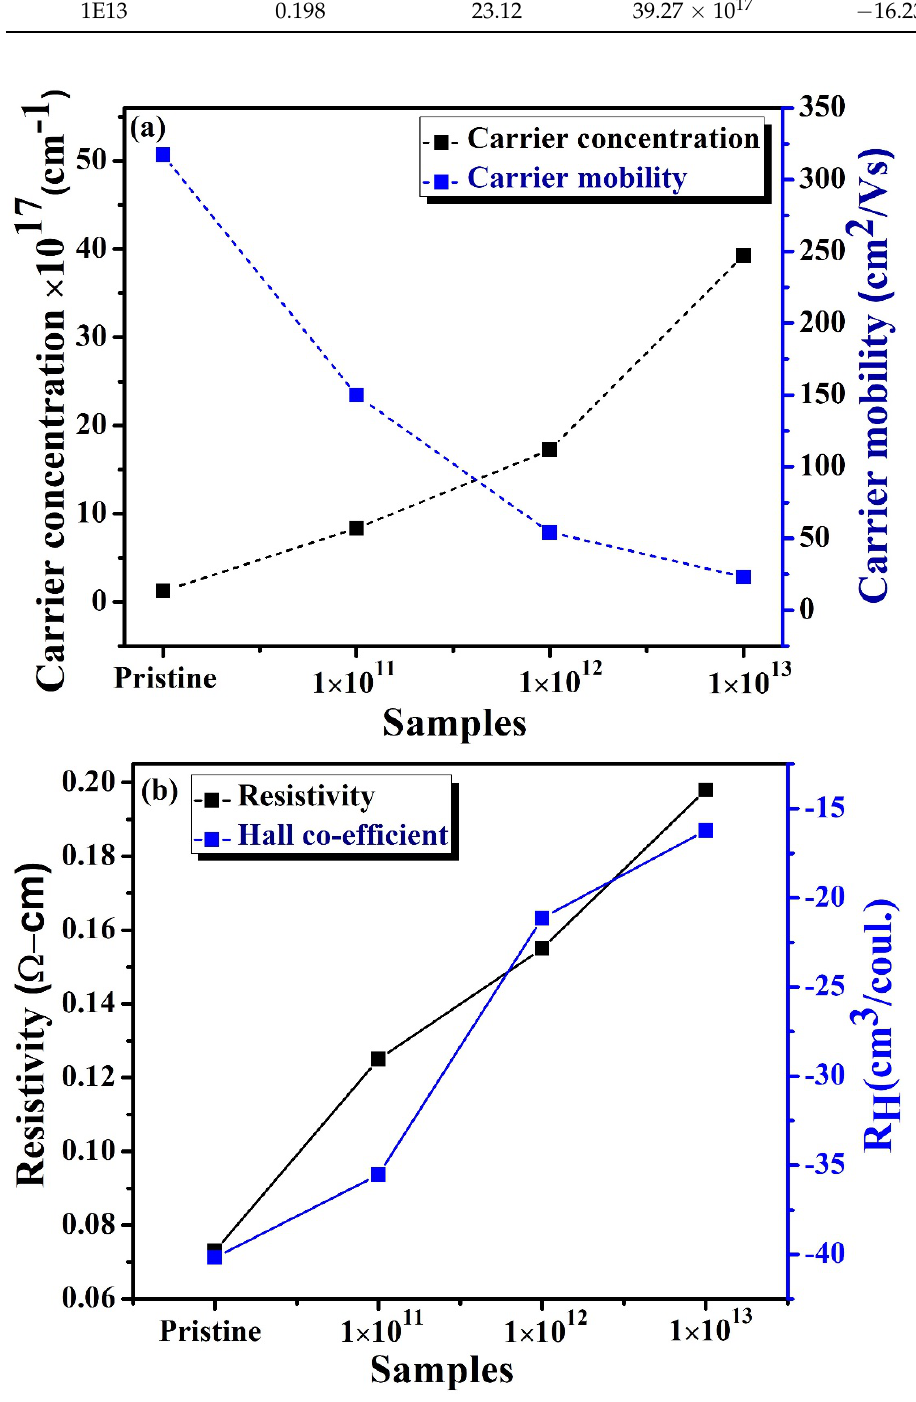
Figure 8. ( a , b ) Hall effect measurements of In 2 (Te 0.98 Se 0.02 ) 3 films.